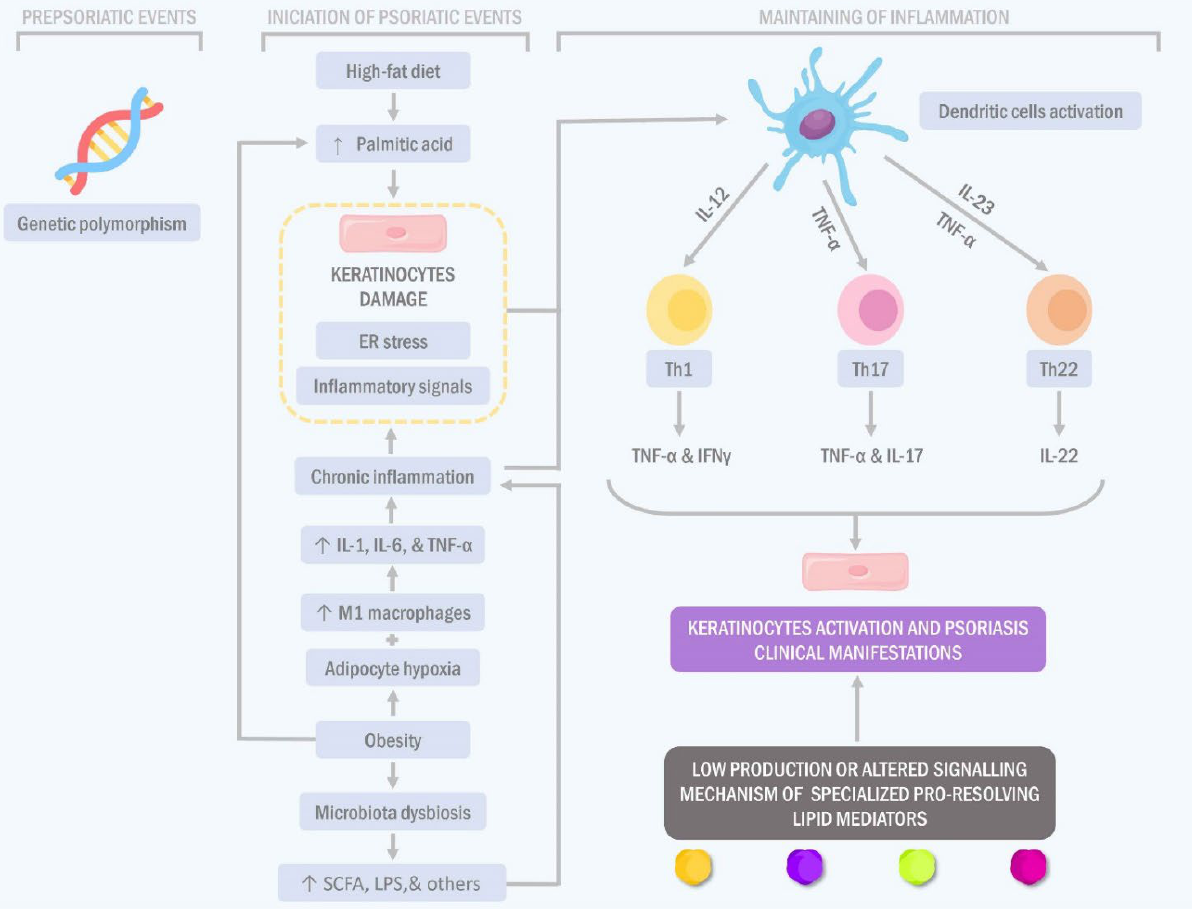
Figure 2. Role of obesity, high-fat diets, and inflammation in the pathophysiology of psoriasis. Psoriasis development has three stages: prior to the processes involved in the disease pathogenesis, the onset of psoriatic events and the maintenance of inflammation associated with psoriasis. Concerning the first stage, genetic polymorphisms play a crucial role. Regarding the onset of the psoriatic events, high-fat diets and obesity may increase palmitic acid levels, which is related to endoplasmic reticulum stress in keratinocytes and adipocytes, leading to a change in their secretory activity and, therefore, the establishment of inflammatory processes. In turn, obesity contributes to establishing a state of hypoxia in the adipose tissue that aggravates local inflammation, which, together with the activation of M1 macrophages, exacerbates the systemic inflammatory state. Obesity and high-fat diets are also associated with intestinal dysbiosis, which may contribute to increased intestinal permeability that allows the passage of pro-inflammatory toxic substances and immune system modulators into the bloodstream. Together, the aforementioned inflammatory processes cause damage to epithelial tissue and keratinocytes. In addition, these mechanisms are capable of activating cells of the immune lineage, such as dendritic cells and T-helper lymphocytes (Th1, Th17 and Th22). Systemic inflammation and exacerbated activation of keratinocytes cause the appearance of the psoriasis lesions. It is worth mentioning that, typically, these mechanisms tend to be resolved by the presence of inflammatory mediators such as specialised pro-resolving lipid mediators; however, their production and signalling mechanisms are altered under these conditions.